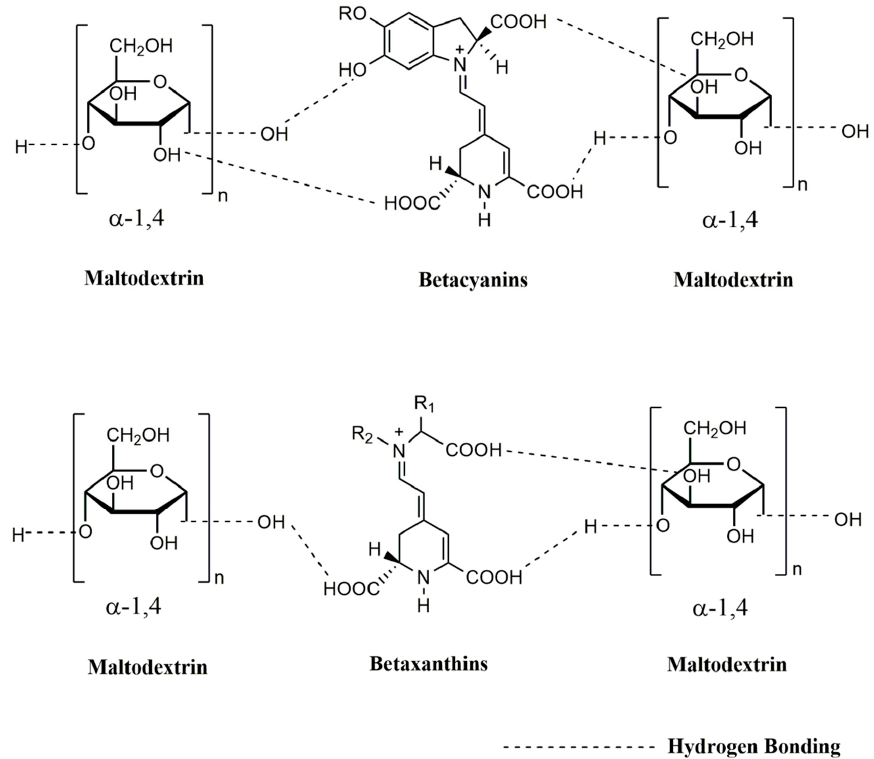
Figure 2. Interaction between maltodextrin with betaxanthins and betacyanins.